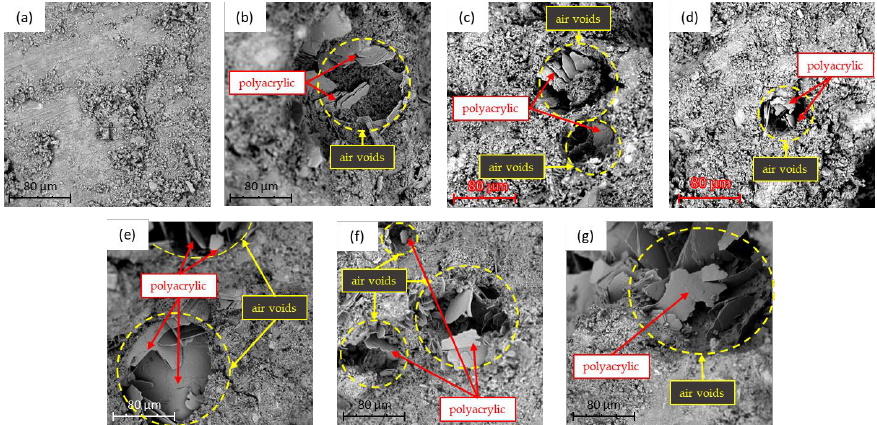
Figure 14. SEM images of the control group and colored cement mortar samples at day 28 with W/C = 0.5: ( a ) control, ( b ) red, ( c ) yellow, ( d ) green, ( e ) blue, ( f ) white, and ( g ) black.